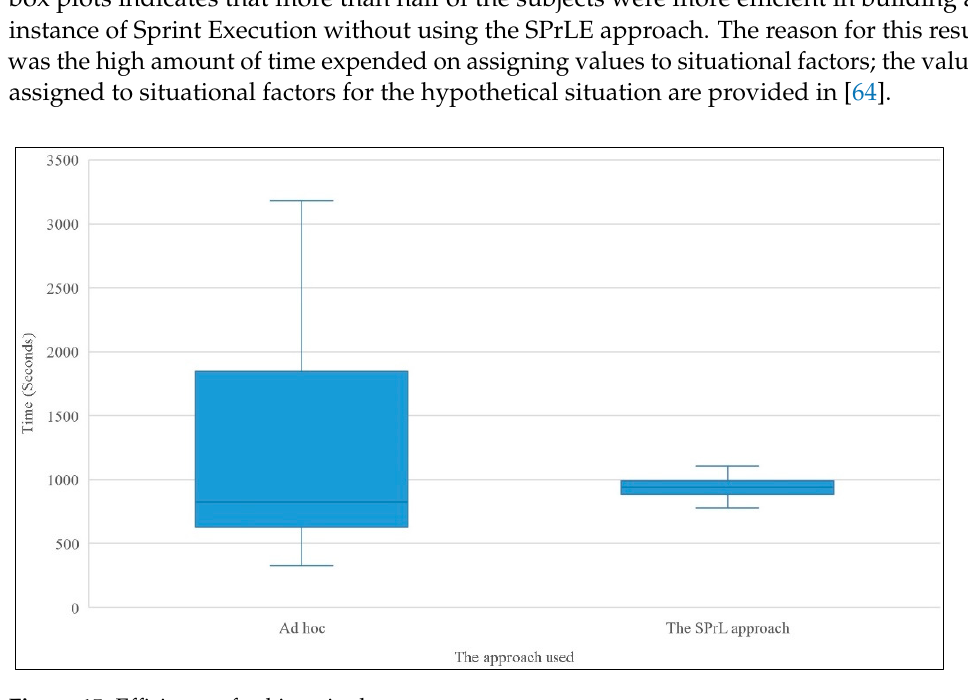
Figure 15. Efficiency of subjects in the two treatments.